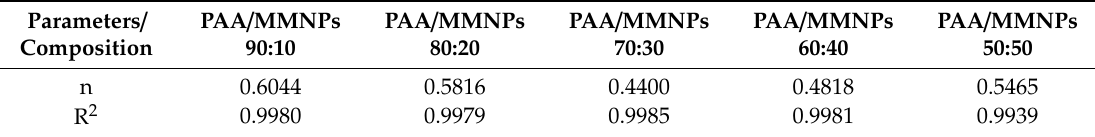
Table 1. The swelling di ff usion coe ffi cient and the regression model-R 2